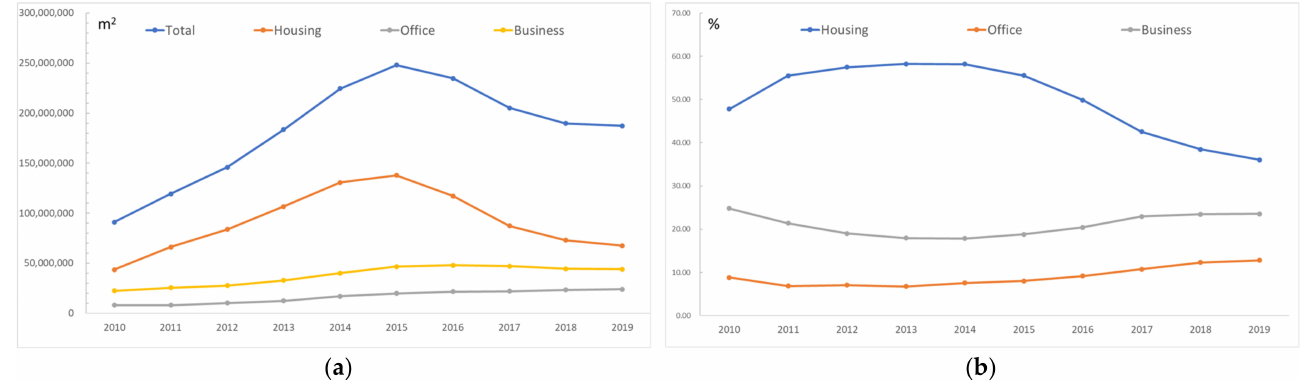
Figure 3. Analysis of real estate inventory change from 2010 to 2019 in the study area ( a ) area; ( b ) proportion.